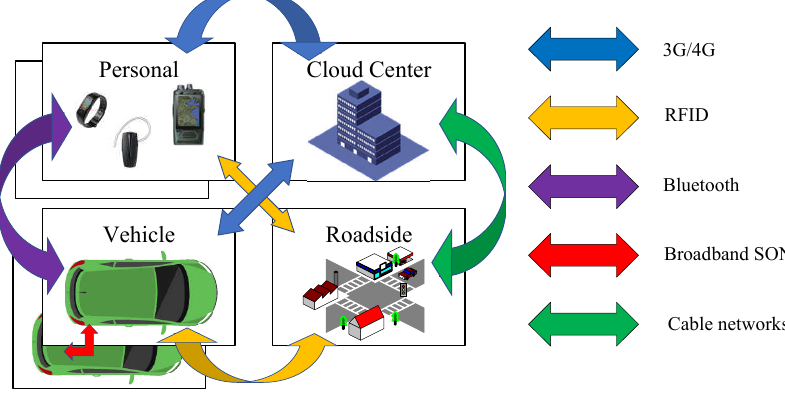
Figure 7. Communication systems in ICV.